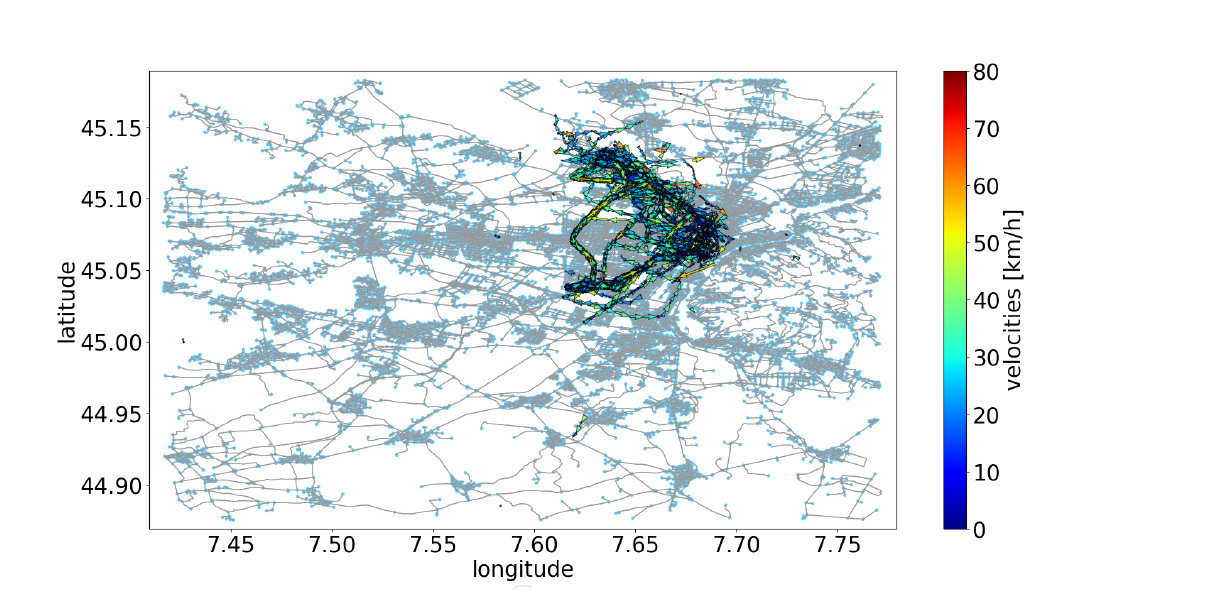
Figure 5. Velocities in the case of line 11 after the outlier